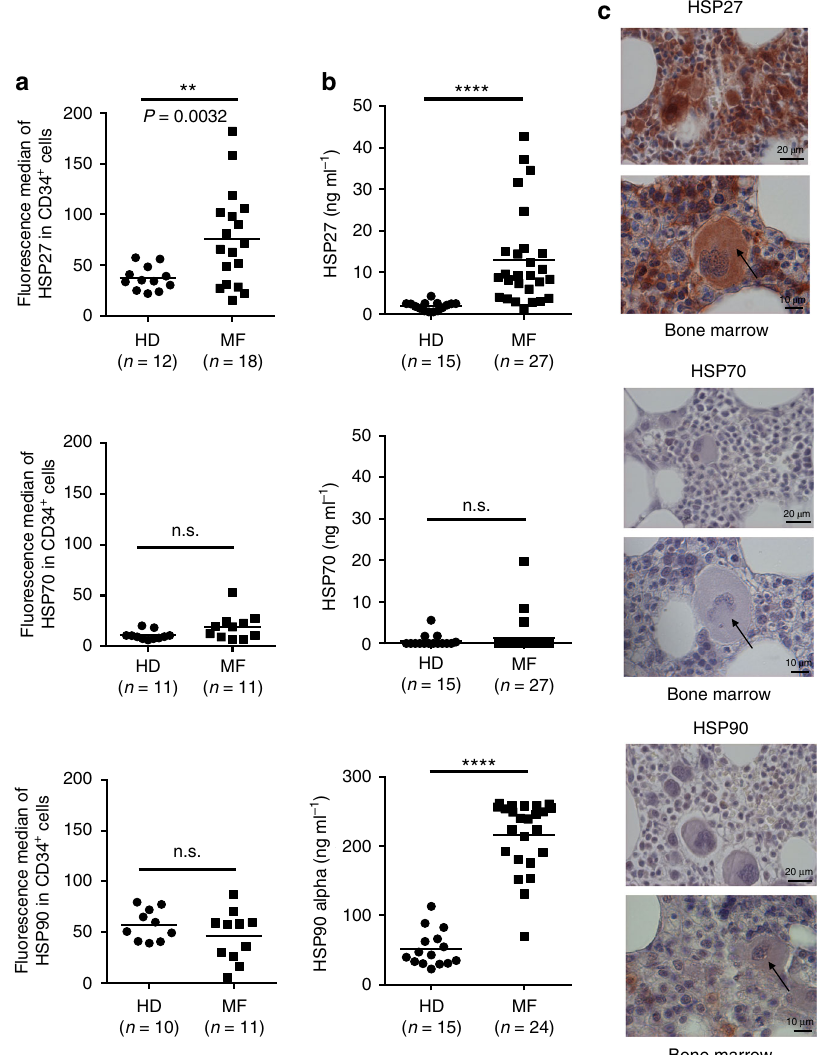
Fig. 6 HSP27 is overexpressed in patients with MPN-associated MF. a Flow cytometry analysis of HSP27, HSP70 and HSP90 in circulating hematopoietic progenitor CD34 + cells from patients with myelo fi brosis (MF) and healthy control donors (HDs) (number of samples analysed; MF: n = 11 – 18; HD: n = 10 – 12). P values were calculated by using the unpaired t test with Welch ’ s correction. ** P < .01; n.s. not signi fi cant. Expression levels of HSP27, HSP70 and HSP90 from MF patients were plotted as median fl uorescence intensities. b Analysis of HSP27, HSP70 and HSP90 levels in the serum of patients with MF ( n = 24-27) compared with HDs ( n = 15) measured by ELISA. P values were calculated using the Mann – Whitney test. **** P < .0001. c Representative histological sections of bone marrow from MF patients. Images were obtained using Cell Observer (Zeiss, France) at two different magni fi cations (×23, scale bar 20 µ m and ×63, scale bar 10 µ m) and Axiovision software. Arrows show